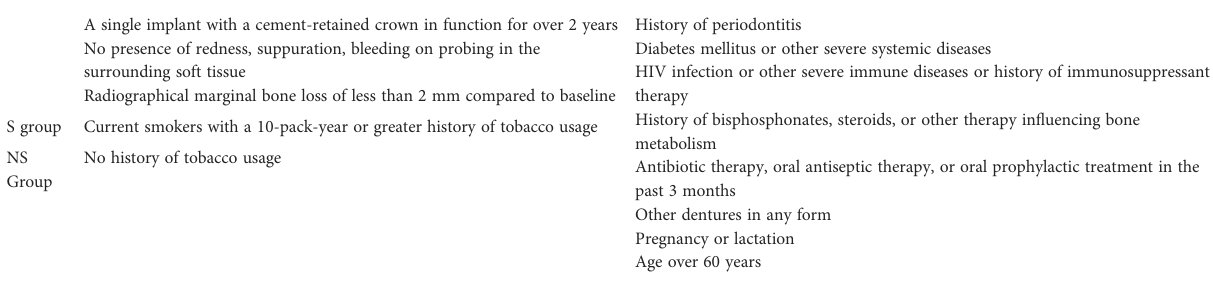
TABLE 1 Detailed inclusion and exclusion criteria.